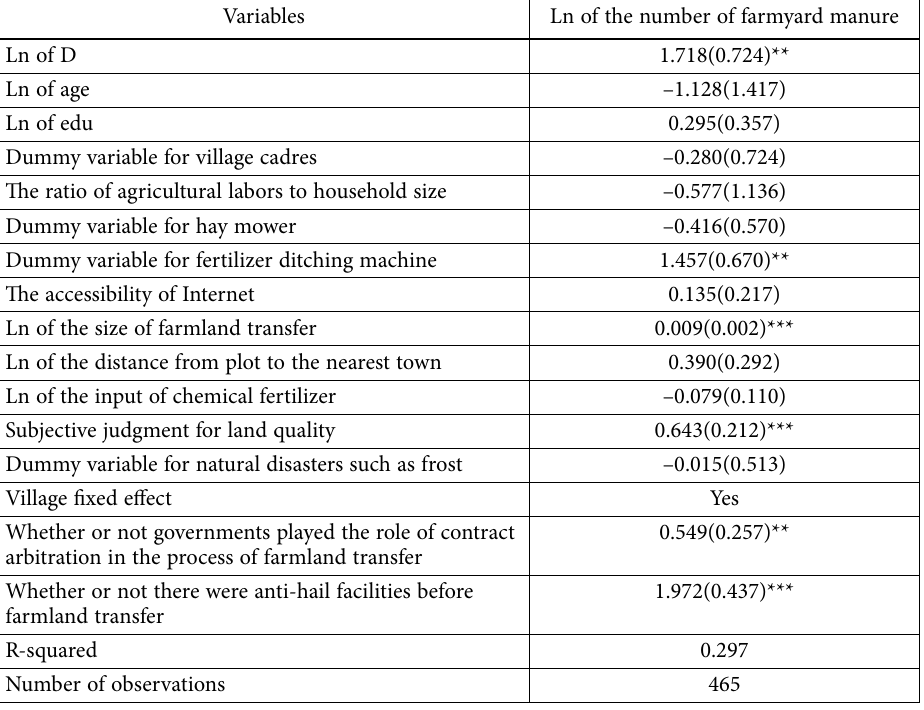
Table 4. Land rents and farmland